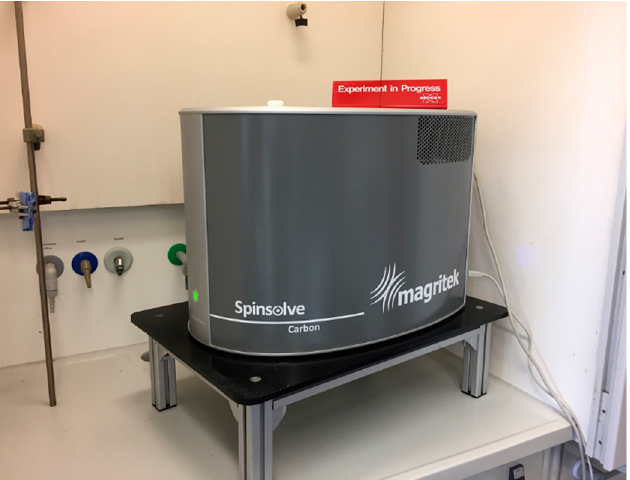
Figure 7. Photo of the utilized Spinsolve placed inside a fume hood in a chemistry laboratory.